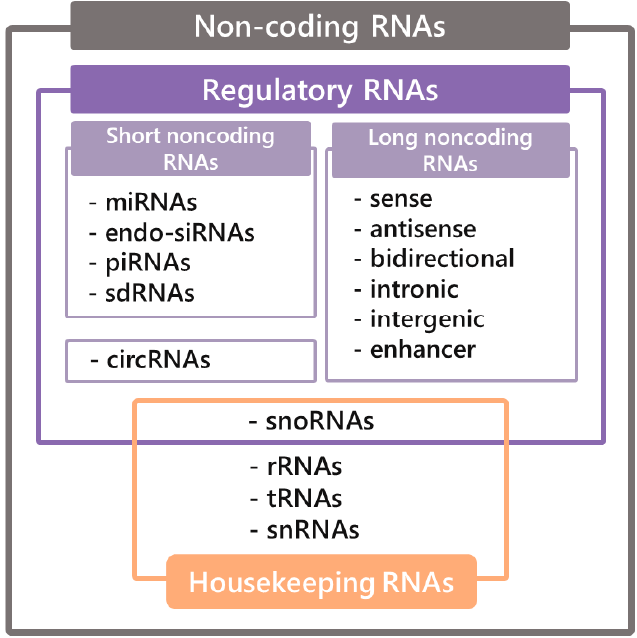
Figure 1. Classification of non-coding RNAs.